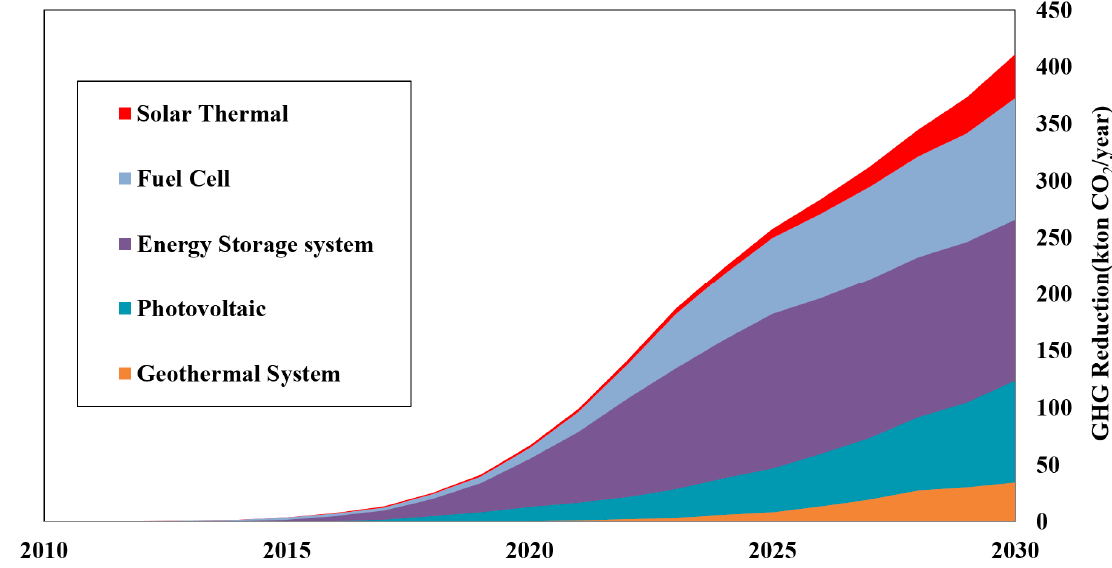
Figure 4. CO 2 emissions reduction potential of the Renewable Energy Supply Target (REST) scenario.